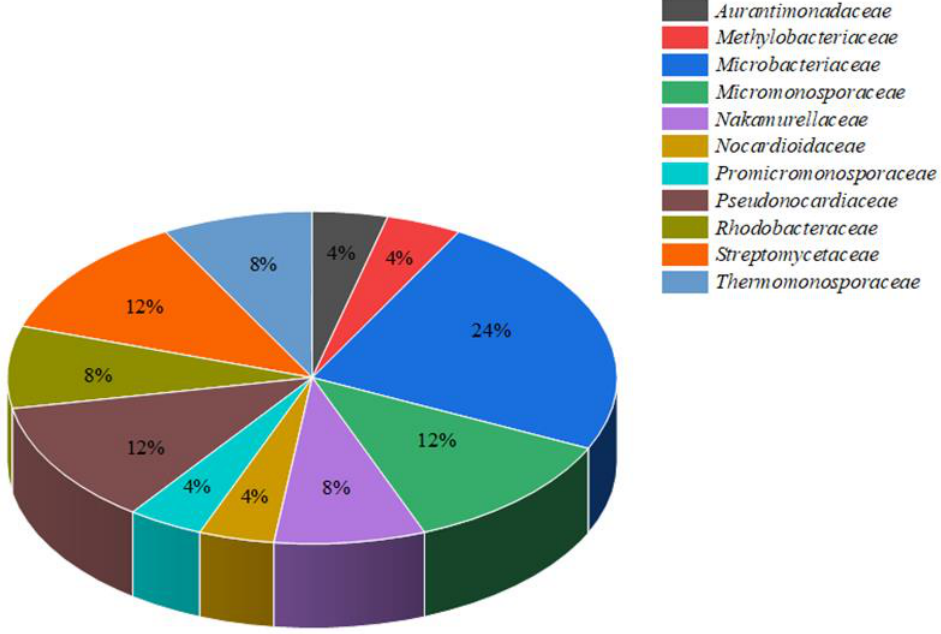
Figure 2. The proportions of novel actinomycete species belonging to different families.